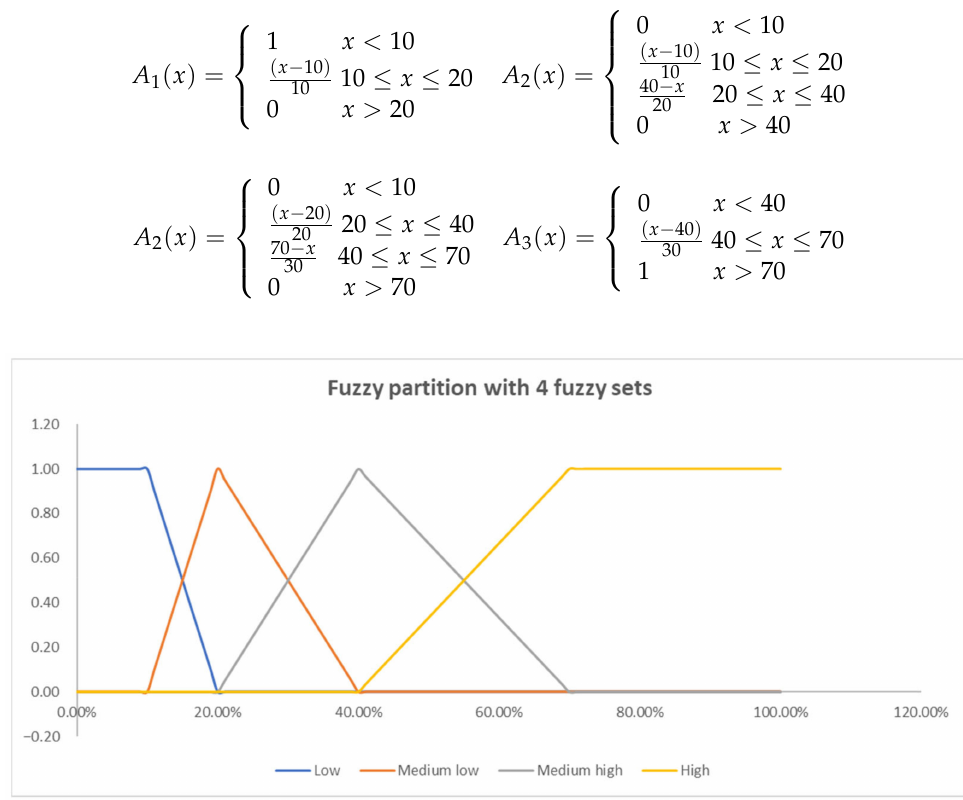
Figure 4. Example of fuzzy partition of the domain [0%,100%] with 4 fuzzy sets.